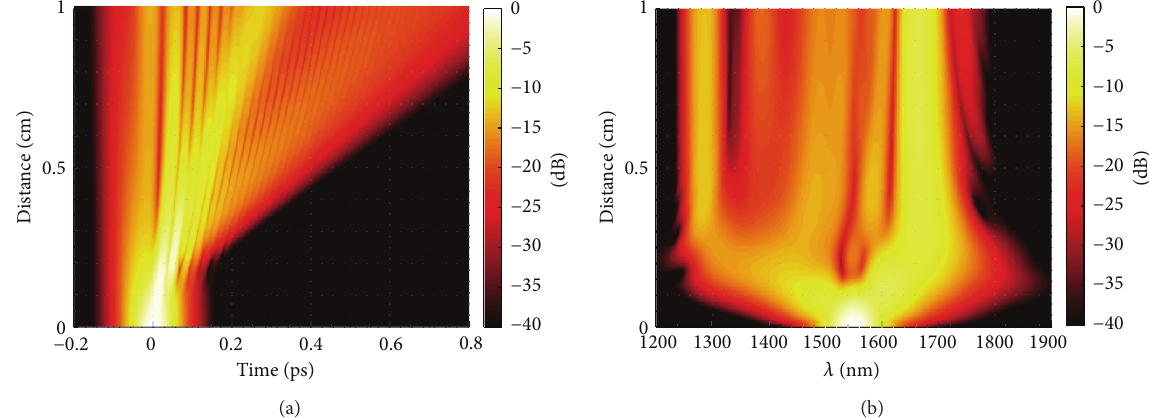
Figure 7: Results from numerical simulations showing (a) temporal and (b) spectral evolution for 1cm long silicon waveguide. The input soliton is 50 fs (FWHM), 50 W peak power hyperbolic secant soliton with order 𝑁 = 6 .